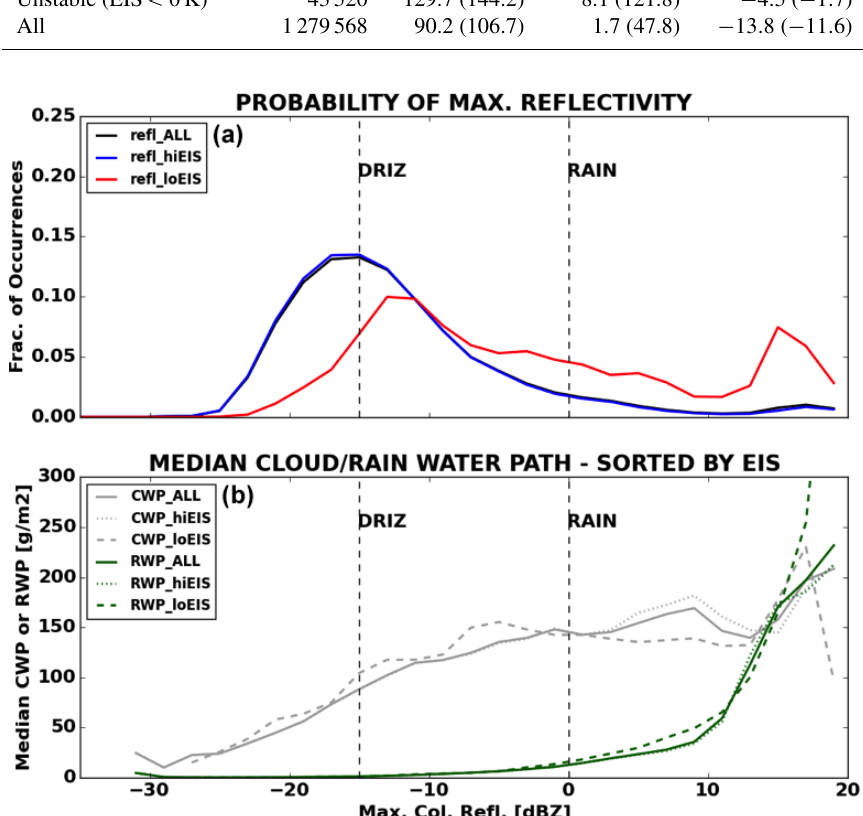
Figure 10. The fractional occurrence of maximum column reflectivity in APR-3-detected clouds (a) as well as median CWP and RWP values corresponding to maximum column reflectivity bins (b) . Each panel is partitioned further by estimated inversion strength (EIS) denoted by blue (EIS > 0K) and red (EIS < 0K) in panel (a) , while CWP and RWP respectively are denoted by dotted (EIS > 0K) and dashed (EIS < 0K) lines